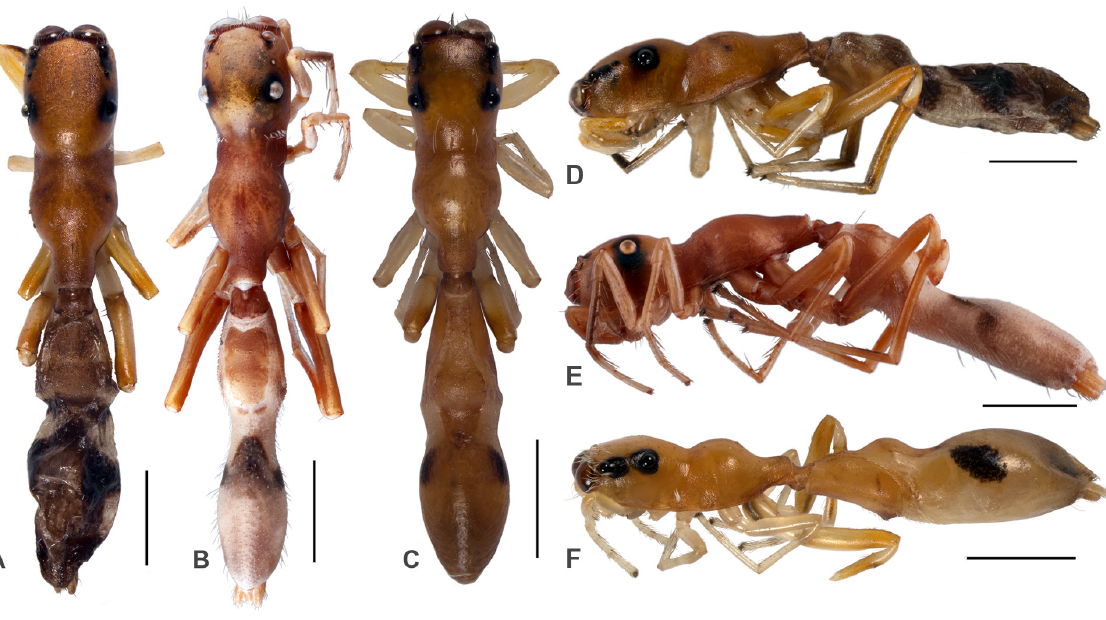
Fig. 4. Dorsal and lateral habitus, females (all CBF). A , D . Synemosyna aurantiaca (Mello-Leitão, 1917). B , E . S. myrmeciaeformis (Taczanowski, 1871). C , F . S. nicaraguaensis Cutler, 1993. Scale bars = 1